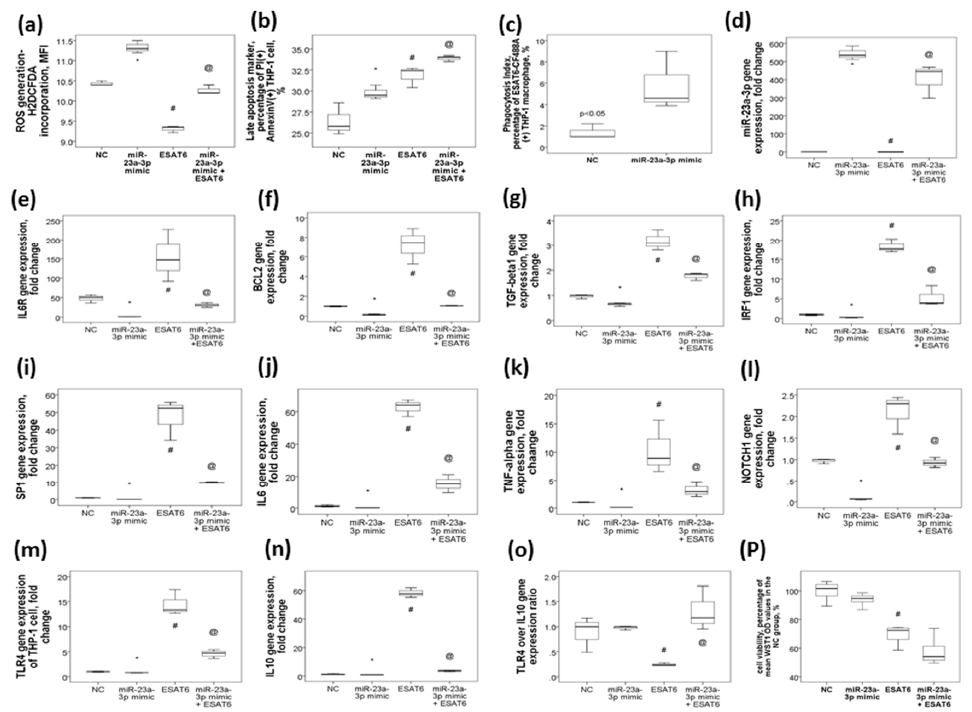
Figure 4. The effect of miR-23a-3p mimic transfection on monocyte/macrophage function and gene expressions of the miR-23a-3p and its target genes under the stimuli of ESAT6 in THP-1 cells. Transfection with miR-23a-3p mimic in THP-1 cells followed by ESAT6 stimuli for 24 h resulted in ( a